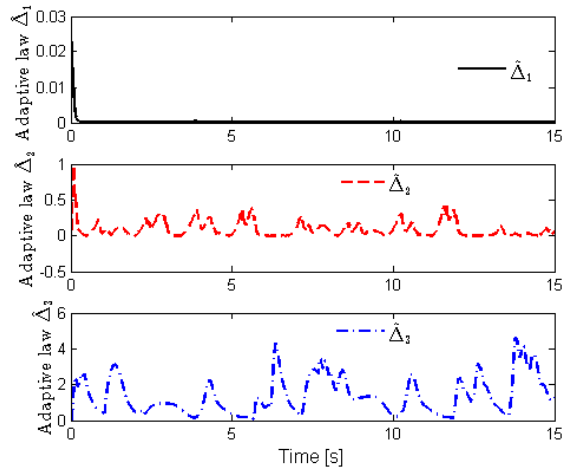
Δ ( 1,2,3 i = ). Δ ( 1,2,3 i = ). i i